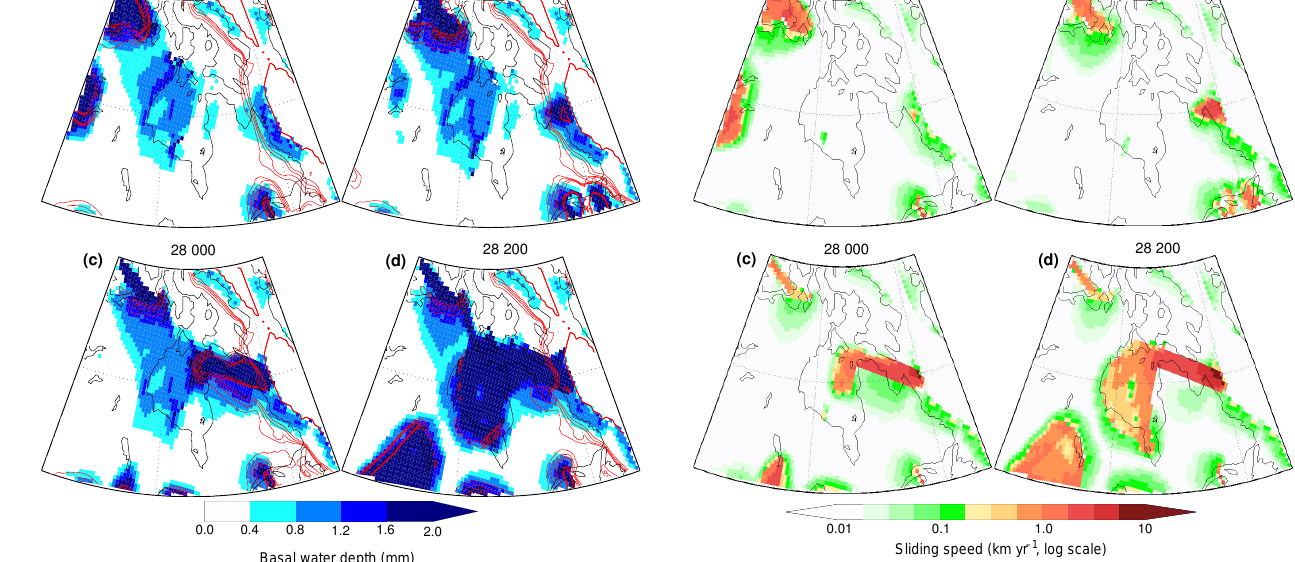
Figure 6. Time slices of the basal water depth field taken at (a) 27000 years, (b) 27500 years, (c) 28000 years and (d) 28200 years. The times shown are the same as those in Fig. 5. When water depths reach 2mm, the maximum shading, the sliding parameter C takes a value of 0.5 C o . The contours show selected values of the gradient of the geopotential in order to show the pas- sage of the activation wave.